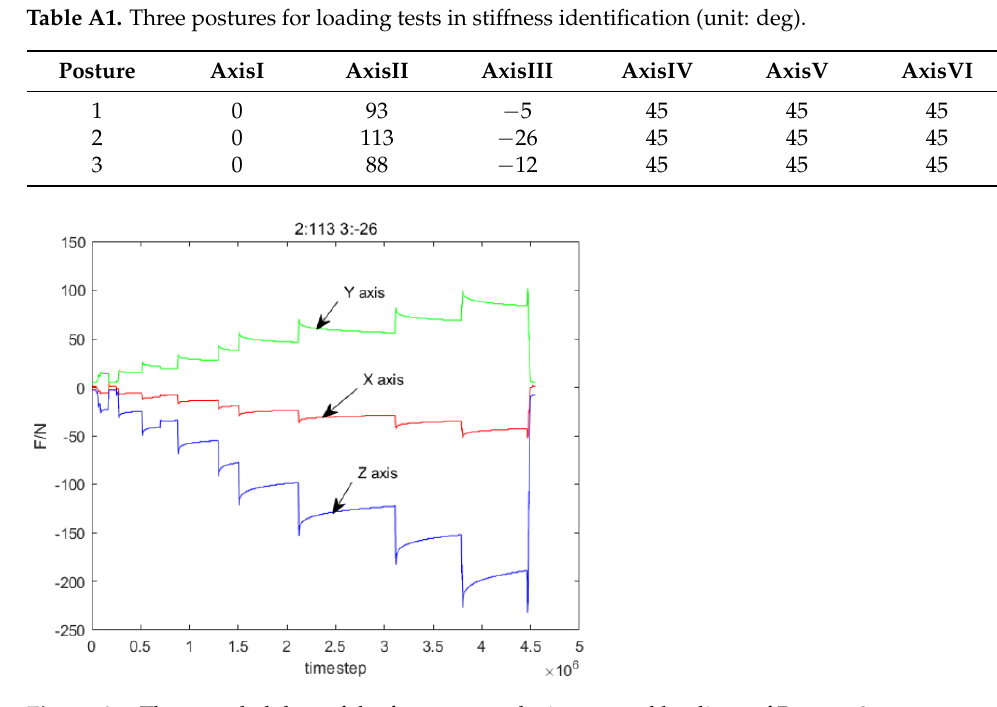
Figure A1. The recorded data of the force sensor during several loadings of Posture